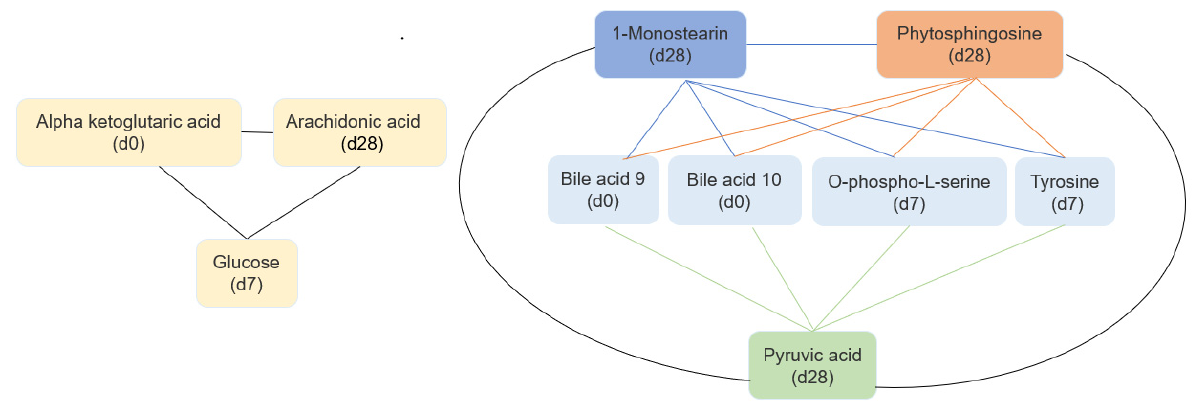
Figure 7. Correlated features between metabolites, similar ranking score (machine learning anal- yses).